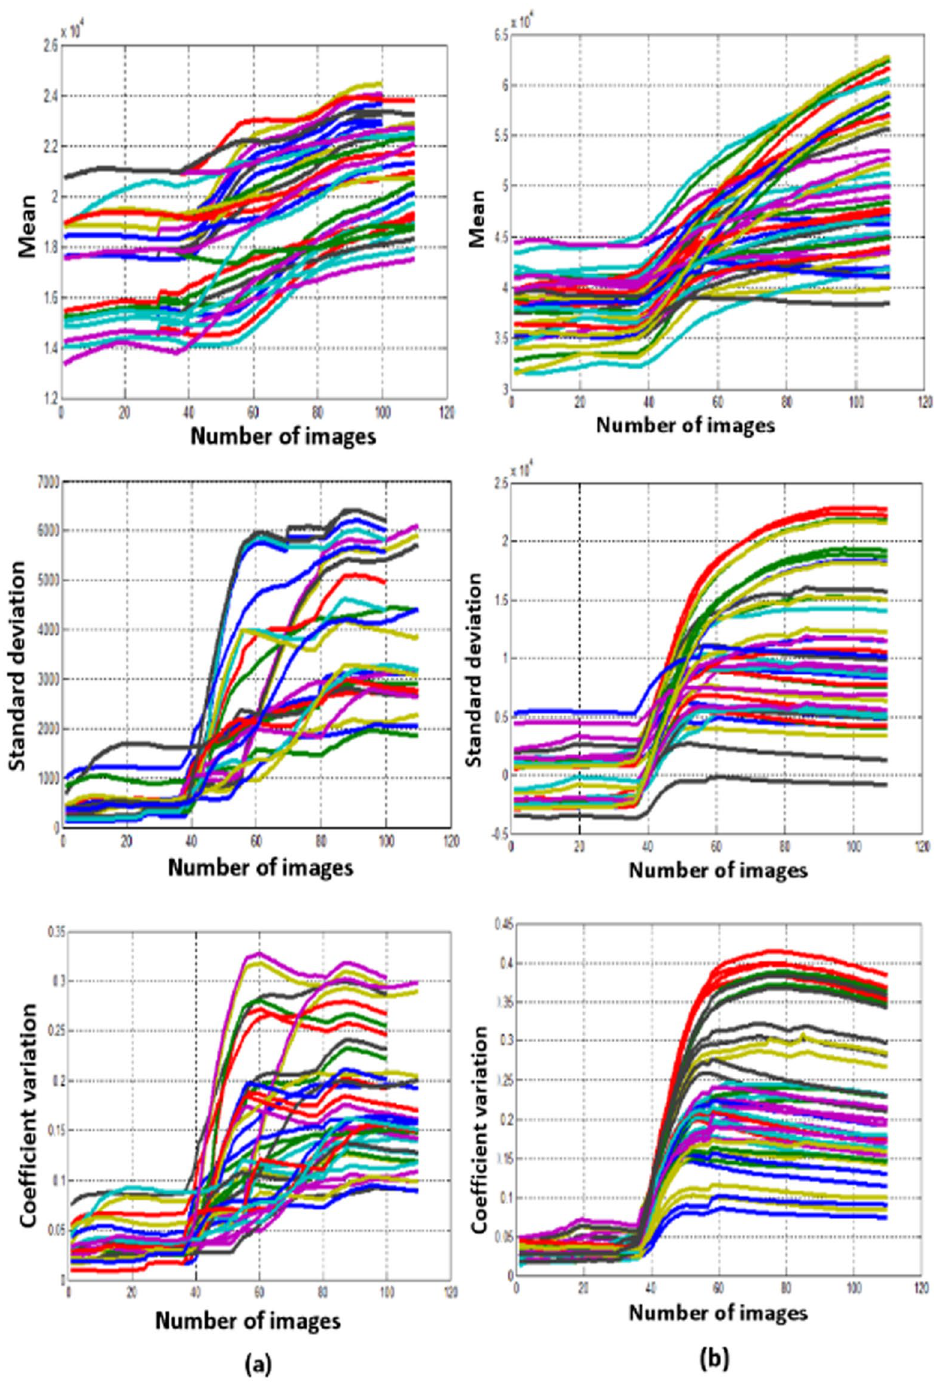
Figure 4. Plots of statistical measurements. (case a ) Mean, SD and CV of box-counts corresponding to the PR intervals. (case b ) Mean, SD and CV of box-counts corresponding to the QRS